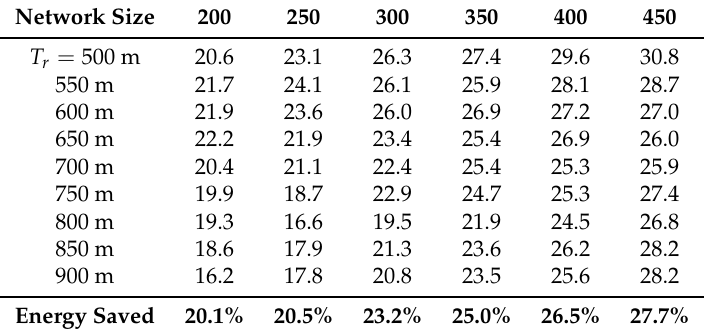
Figure 13. Overall network energy consumption for varying number of data packets generated by the source nodes in the network. Table 1. Overall energy saved by the proposed scheme compared to